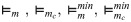
Relations among five entailments: ⊨, ⊨m,⊨mc,⊨mmin,⊨mcmin.